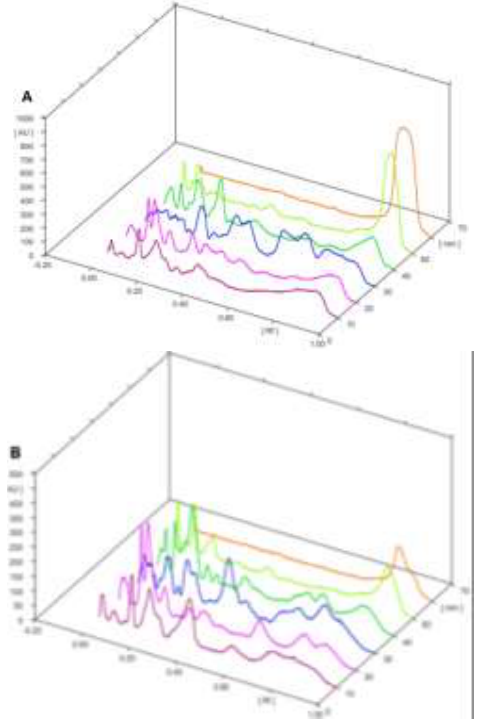
Figure 3. Dimensional fingerprint of ethyl acetate extract from broth medium of E.linearis scanned at 254 nm (A) ; 366 nm (B) . TLC run in silica gel 60 F 254 plate with mobile phase ethyl acetate:chloroform (1:1). Air-based drying device in 27 ℃ temperature. 10mm: 7 days old culture incubated under light; 20mm: 7 days old culture incubated in dark condition; 30mm: 14 days old culture incubated under light; 40mm: 14 days old culture incubated in dark condition; 50mm: 21 days old culture incubated under light; 60mm: 21 days old culture incubated in dark condition . All samples were tested at 100mg/mL in ethyl acetate.